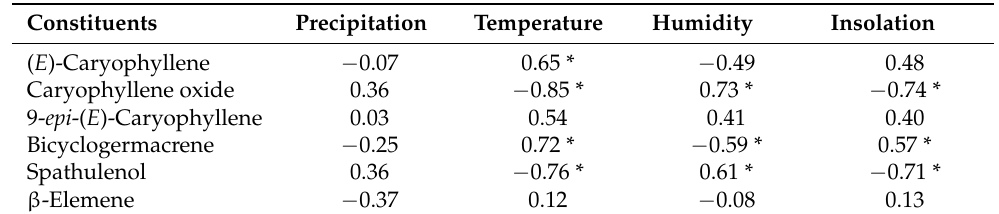
Figure 2. Compound classes and primary constituents of the E. patrisii essential oils on rainy and dried seasons: media and standard deviation. Values with the same letters in the bars do not differ statistically in the Tukey test ( p > 0.05). Table 2. Correlation of E. patrisii essential oil primary constituents with the collection site climatic parameters.